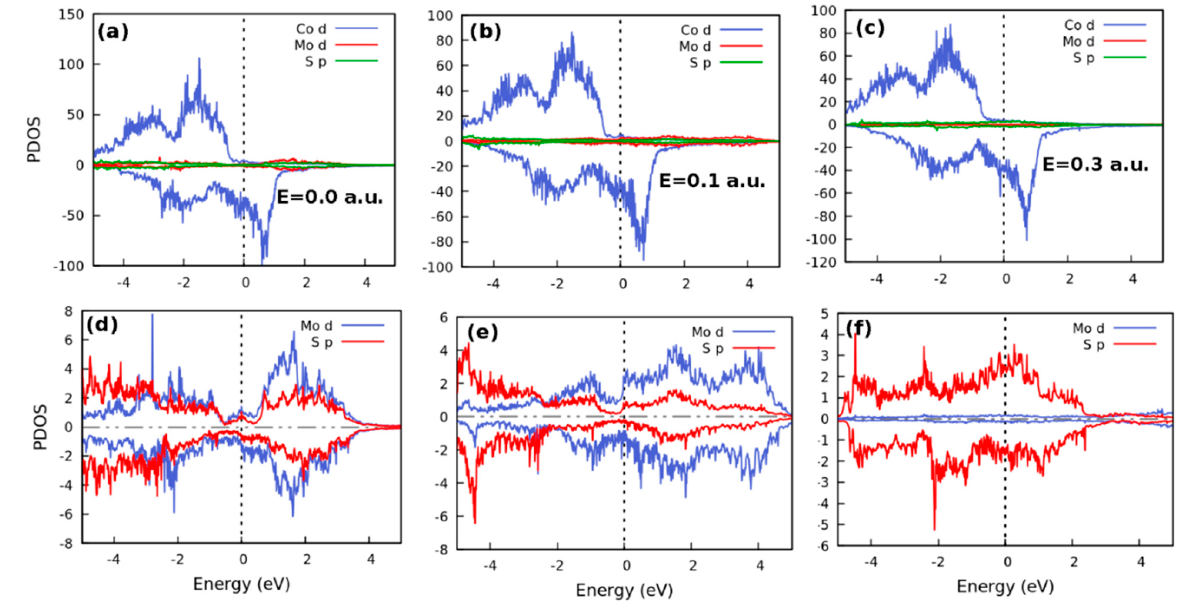
Figure 4. Effect of applied electric field on the spin-polarized orbital-resolved electronic DOS of Co/MoS 2 /Co stack at electric field of 0.0 ( a ), 0.1 ( b ) and 0.3 a.u. ( c ), respectively. The PDOS within the monolayer MoS 2 tunnel barrier region is also displayed in ( d – f ) to show the Mo d -orbital and S p -orbital at the three different magnitudes of the applied electric field. Positive and negative PDOS denote spin-up and spin-down channels, respectively. The vertical dashed lines indicate the Fermi level ( E F ).